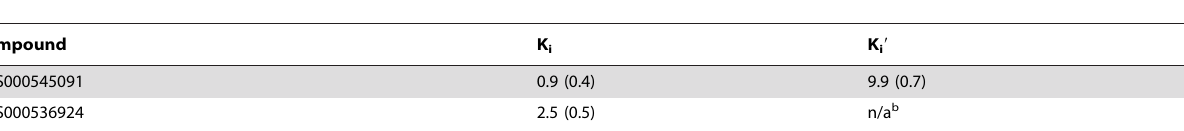
Table 2. Inhibitor K i values with AA from Dixon replots. a